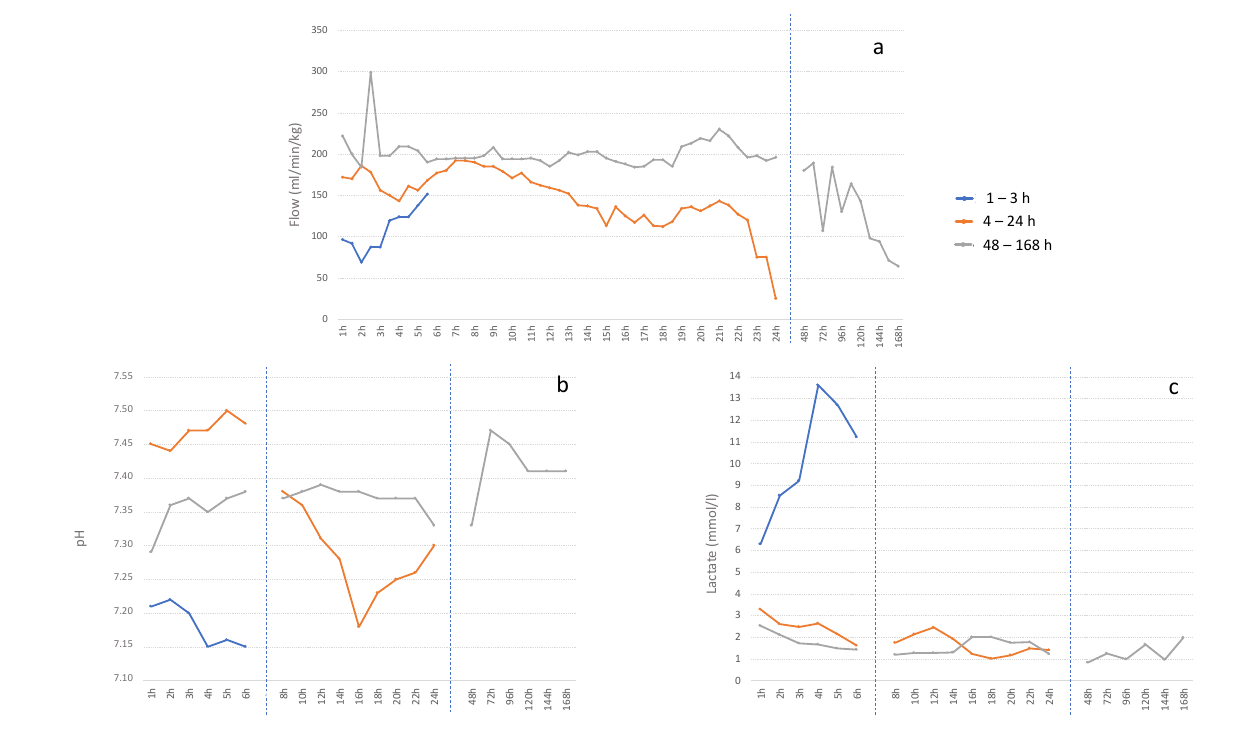
Figure 2. Representative data of the longitudinal evolution in one animal of each experimental group. Graphics showing mean value for each time point of ( a ) circuit flow normalized by fetal weight (ml/kg/min), ( b ) pH and ( c ) lactate (mmol/L).